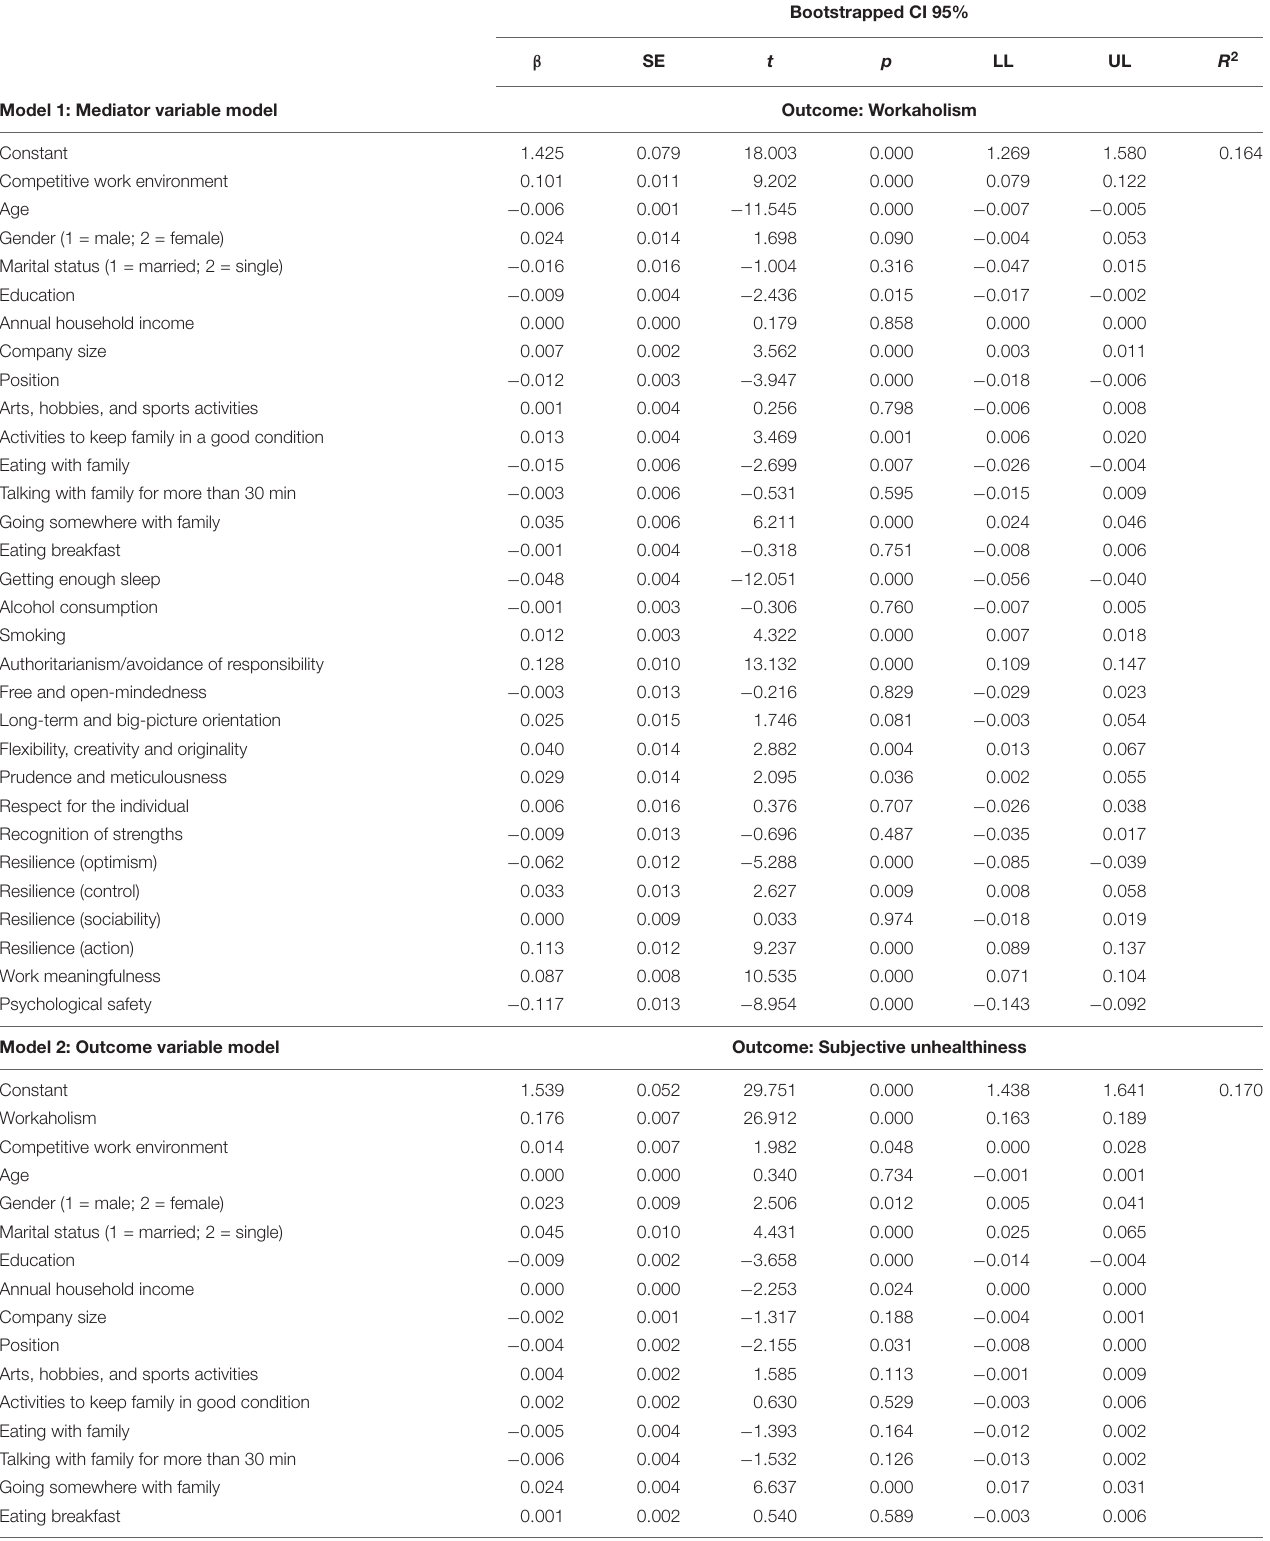
TABLE 2 | Mediation